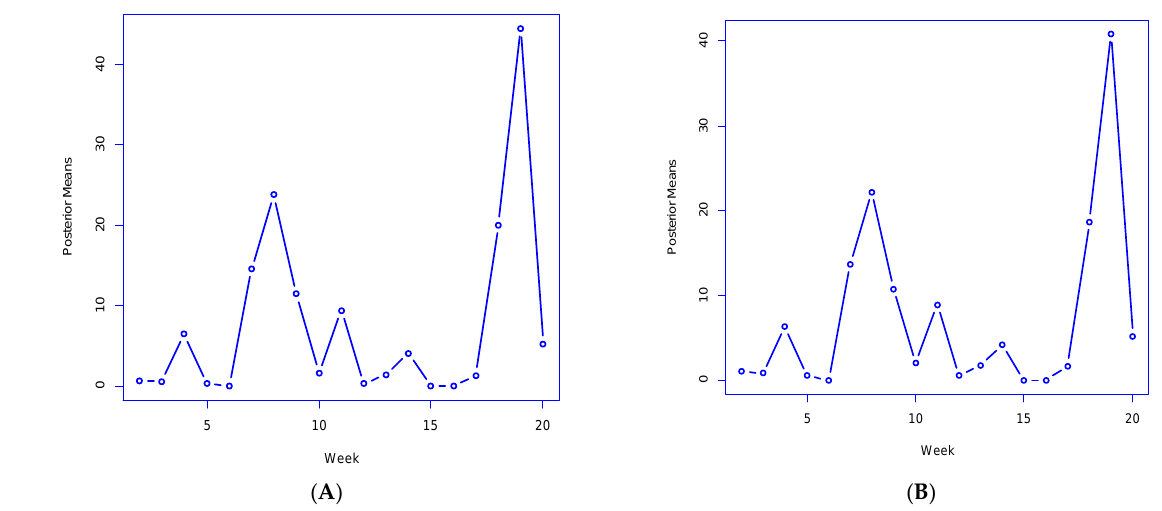
Figure 5A Average Number of Own Area Slopes Exceeding 1, R tx